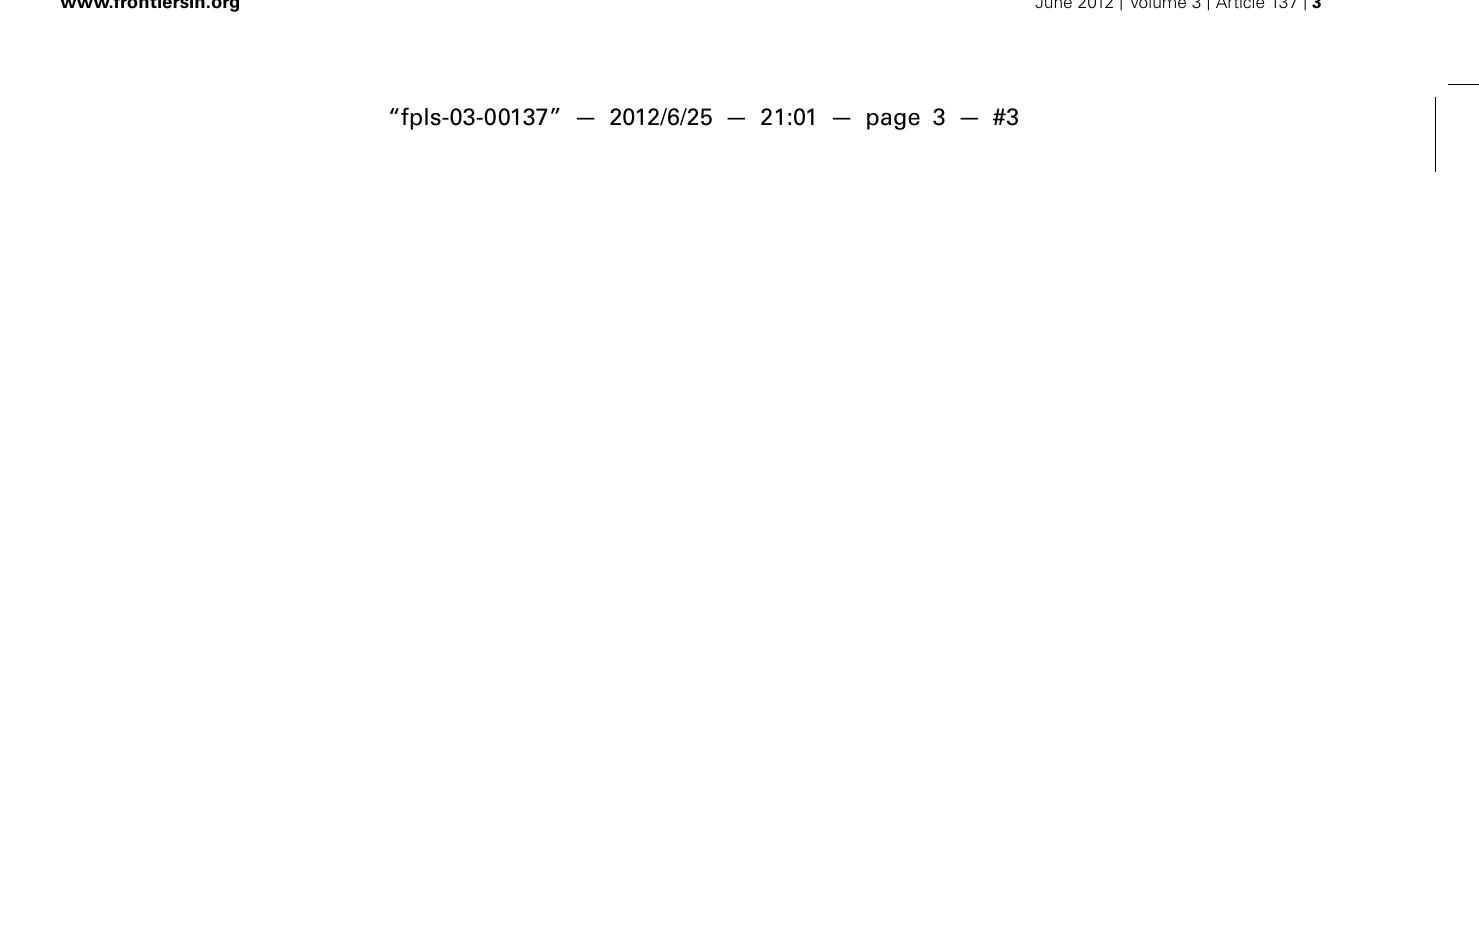
anthesis (A) , while the exposed gynoecium is seen in the female phase (B) . Reproduced from Endress (2008), by permission of Oxford University